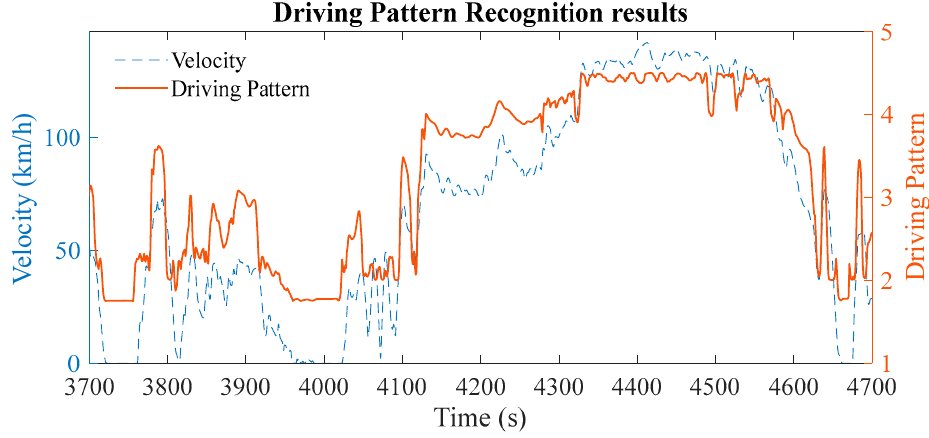
Figure 11. Our new driving pattern recognizer results on Interval1.